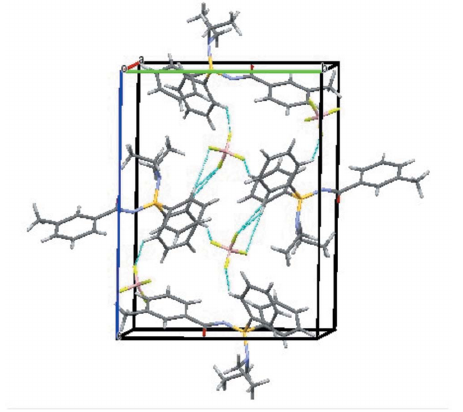
Figure 2 A packing view of the title compound, showing C—H (cid:2)(cid:2)(cid:2) F hydrogen bonds (blue dashed lines).